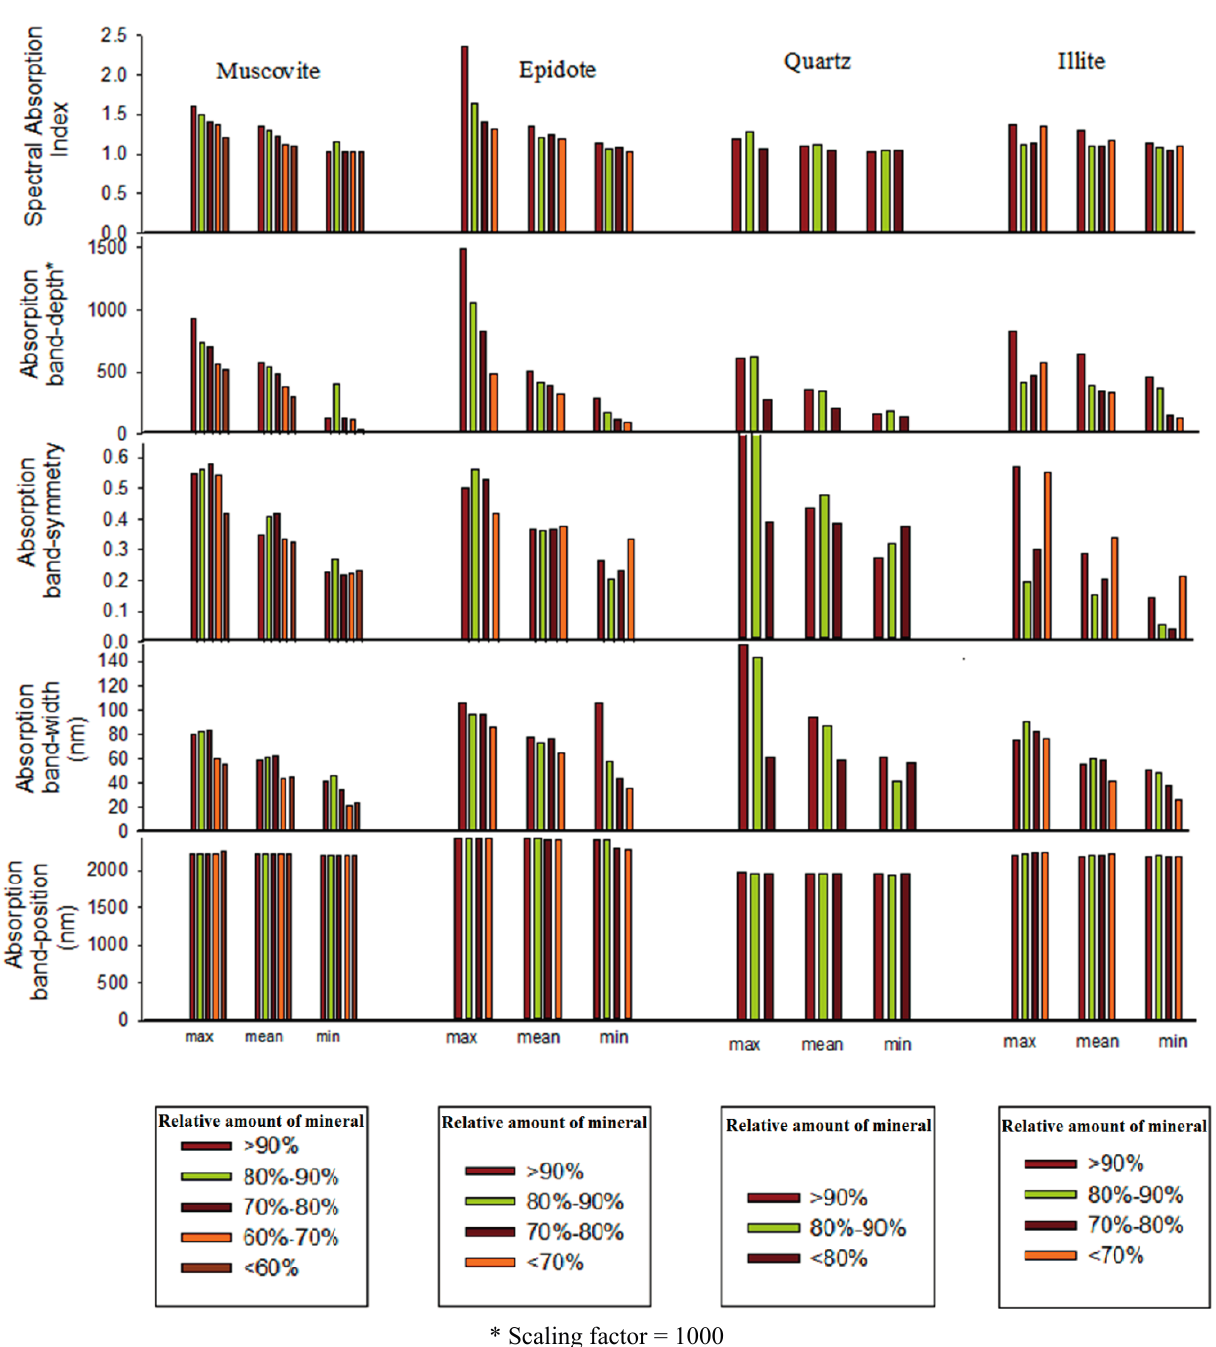
Figure 11. Statistics of spectral absorption features of alteration minerals identified using PIMA and the relationship between the spectral absorption features (including SAI, spectral absorption band-depth, spectral absorption band-width, spectral absorption band-symmetry and spectral absorption composition) and the relative abundance of alteration